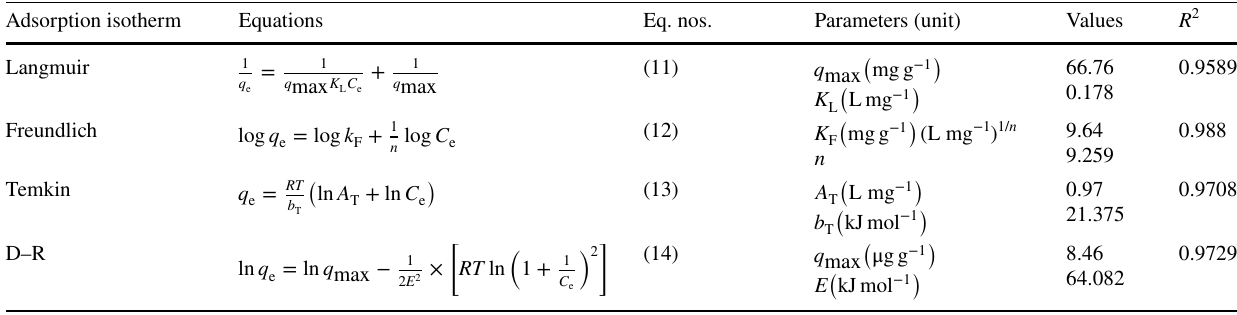
Table 2 Isotherm data for adsorption of glyphosate by EBAC